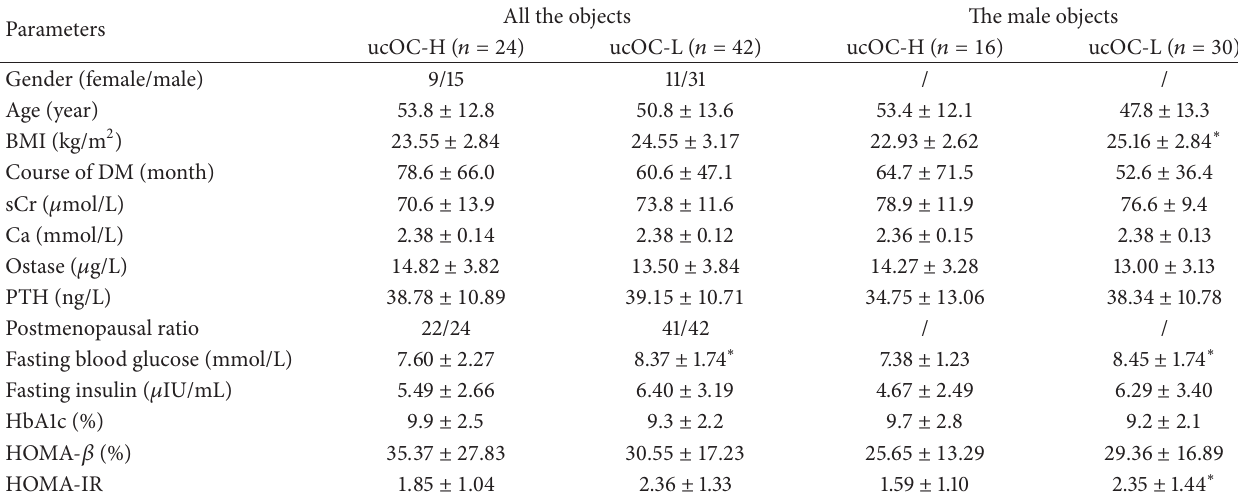
Table 4: Comparisons between Group ucOC-H and Group